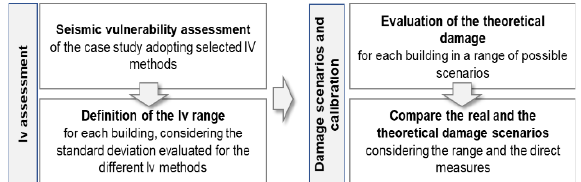
Figure 12. Procedure used in accuracy evaluation of vulnerability assessment